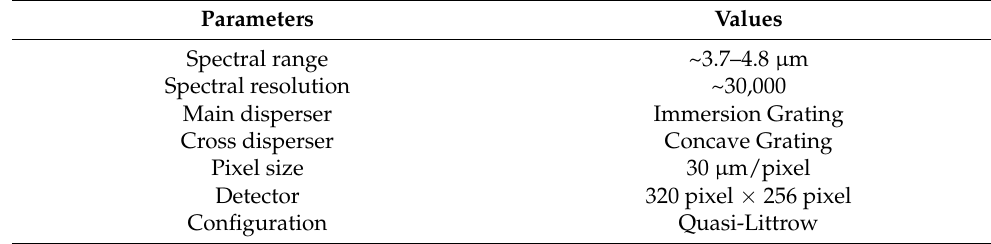
Table 2. Specification requirements of the